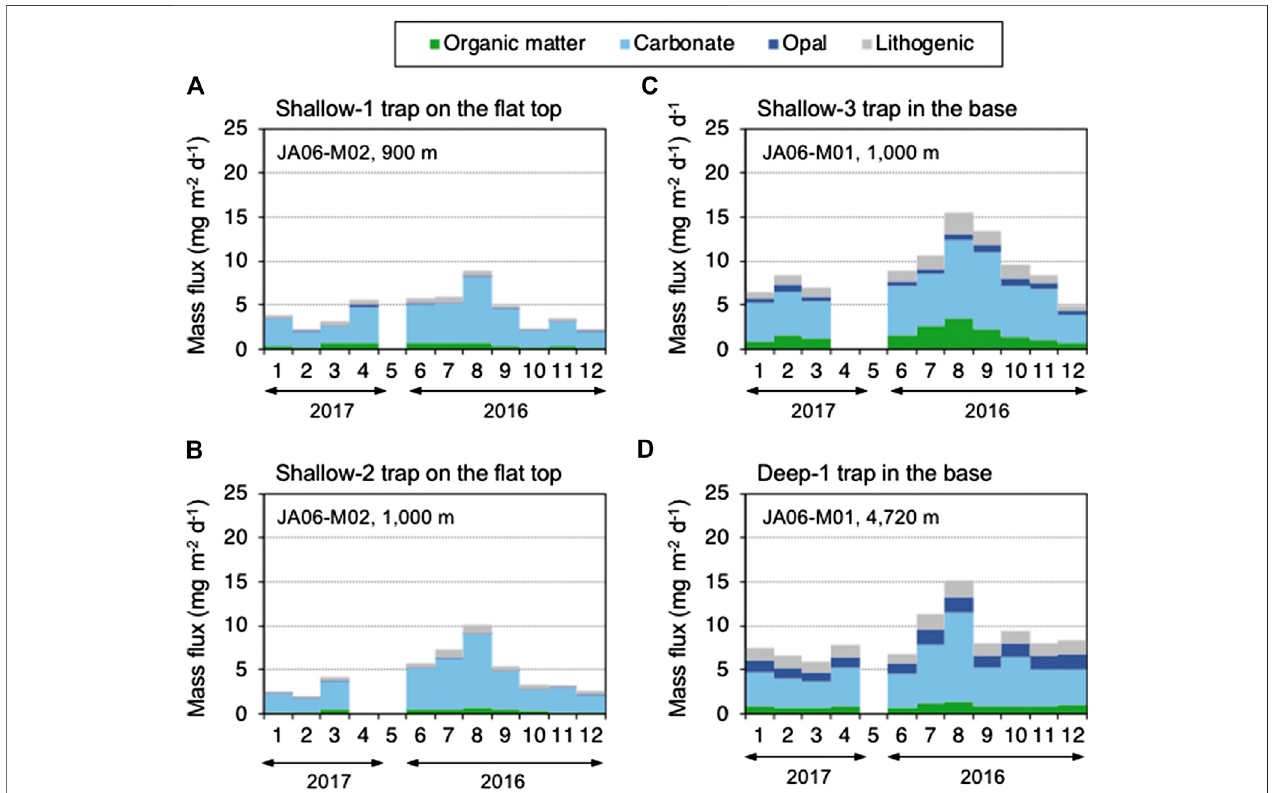
FIGURE 2 | Fluxes of organic matter, carbonate, opal, and lithogenic elements from June 2016 to April 2017 at four sediment traps around JA06 seamount (A) shallow-1 (depth, 900 m) and (B) shallow-2 (1,000 m) at site JA06-M02 on the seamount fl at top, and (C) Shallow-3 (1,000 m) and (D) Deep-1 (4,720 m) at site JA06- M01 on the seamount